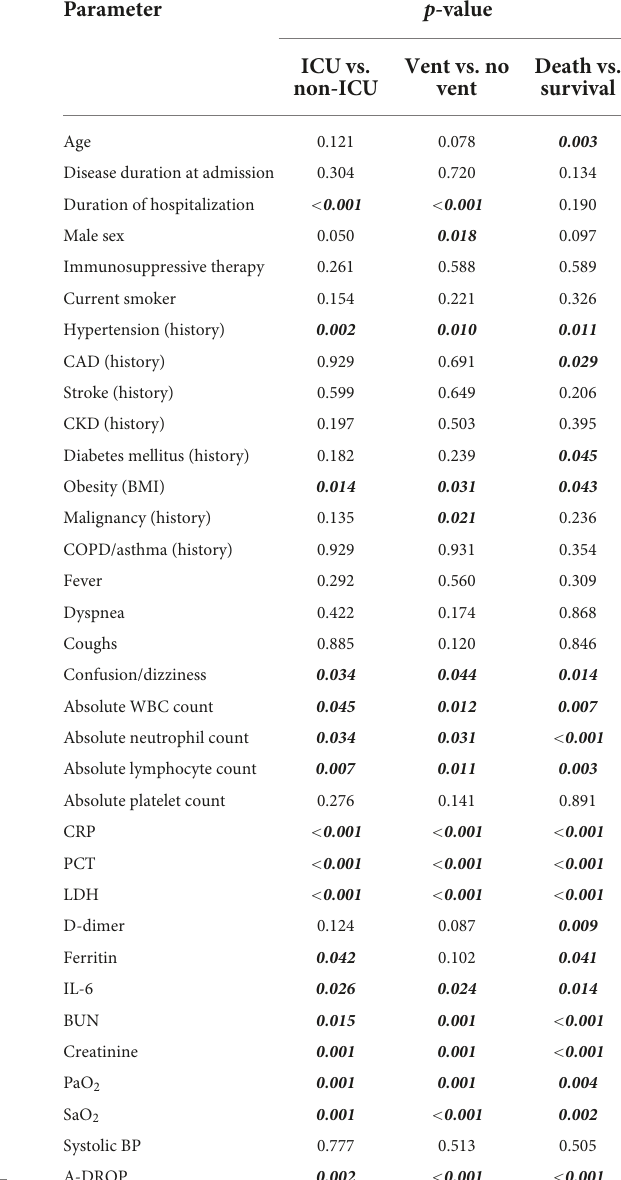
TABLE 2 Determinants of ICU admission, need for ventilation and